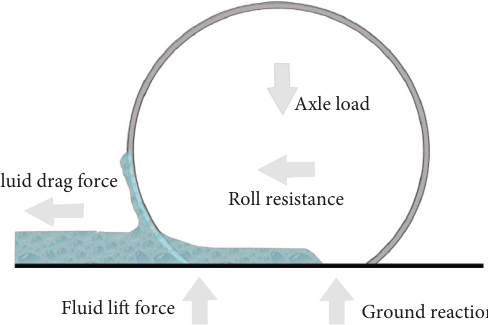
F d is the fluid drag force; F h is the tire axle load; F z is the tire rolling resistance; and F t is the fluid lift force.